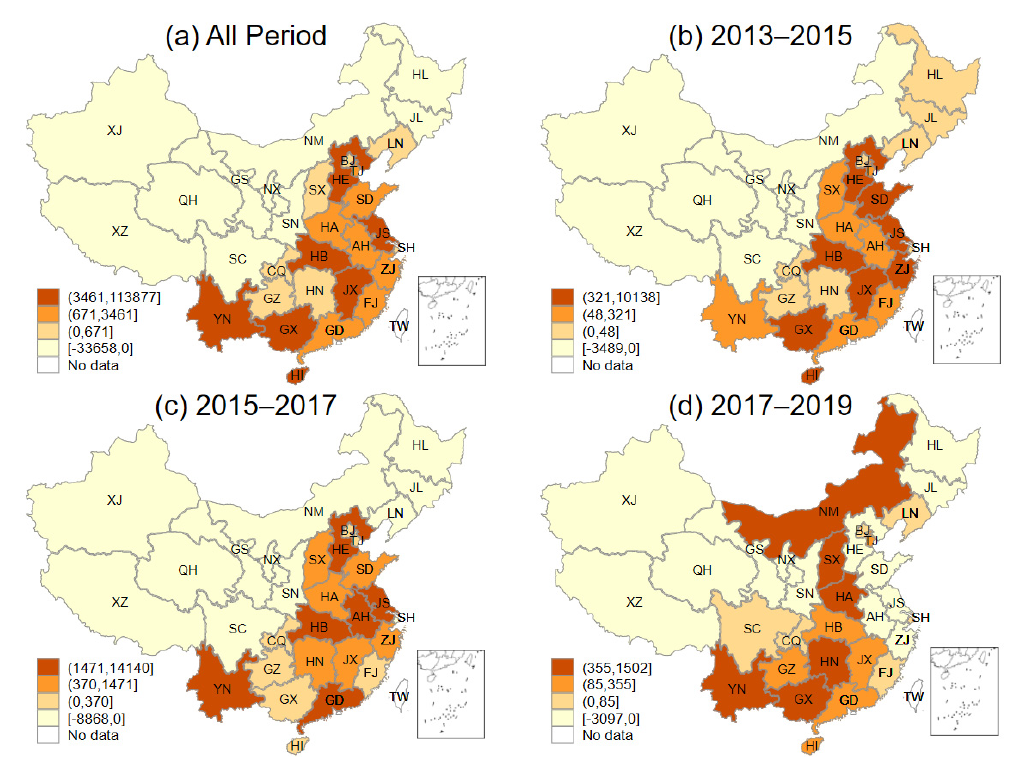
Figure 3. Neighbor–Nation Solar PV Investment Competitive Effect (NNC) Across China Regions: ( a ) all periods; ( b ) 2013–2015; ( c ) 2015–2017; ( d ) 2017–2019.